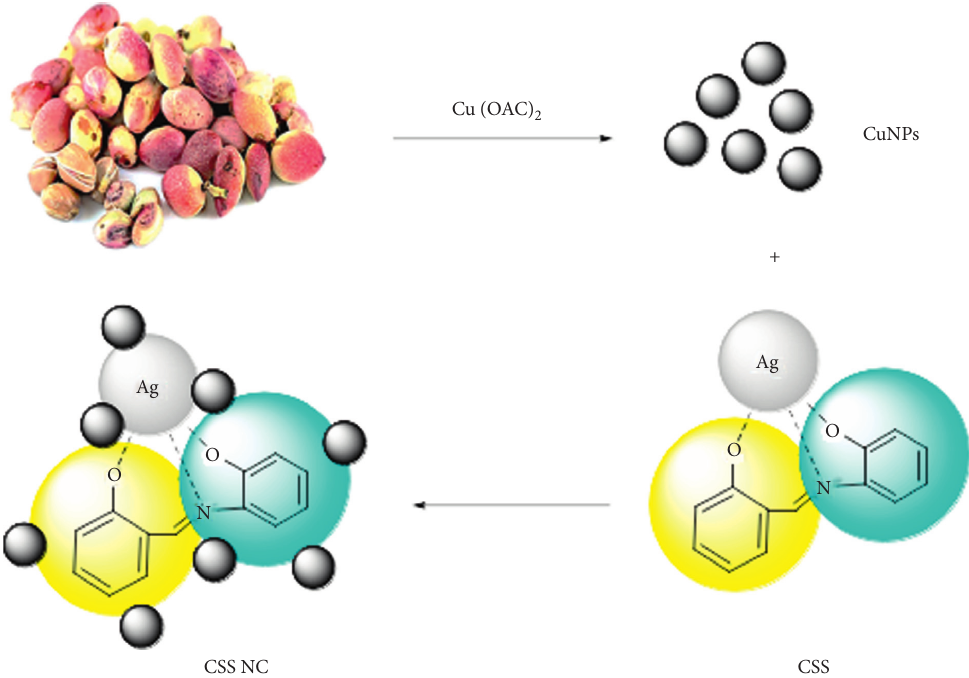
Scheme 4: Chemical reaction of CSS NC